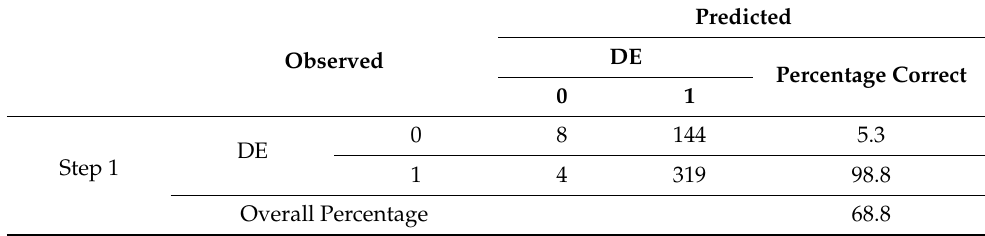
Table 13. Classification Table a